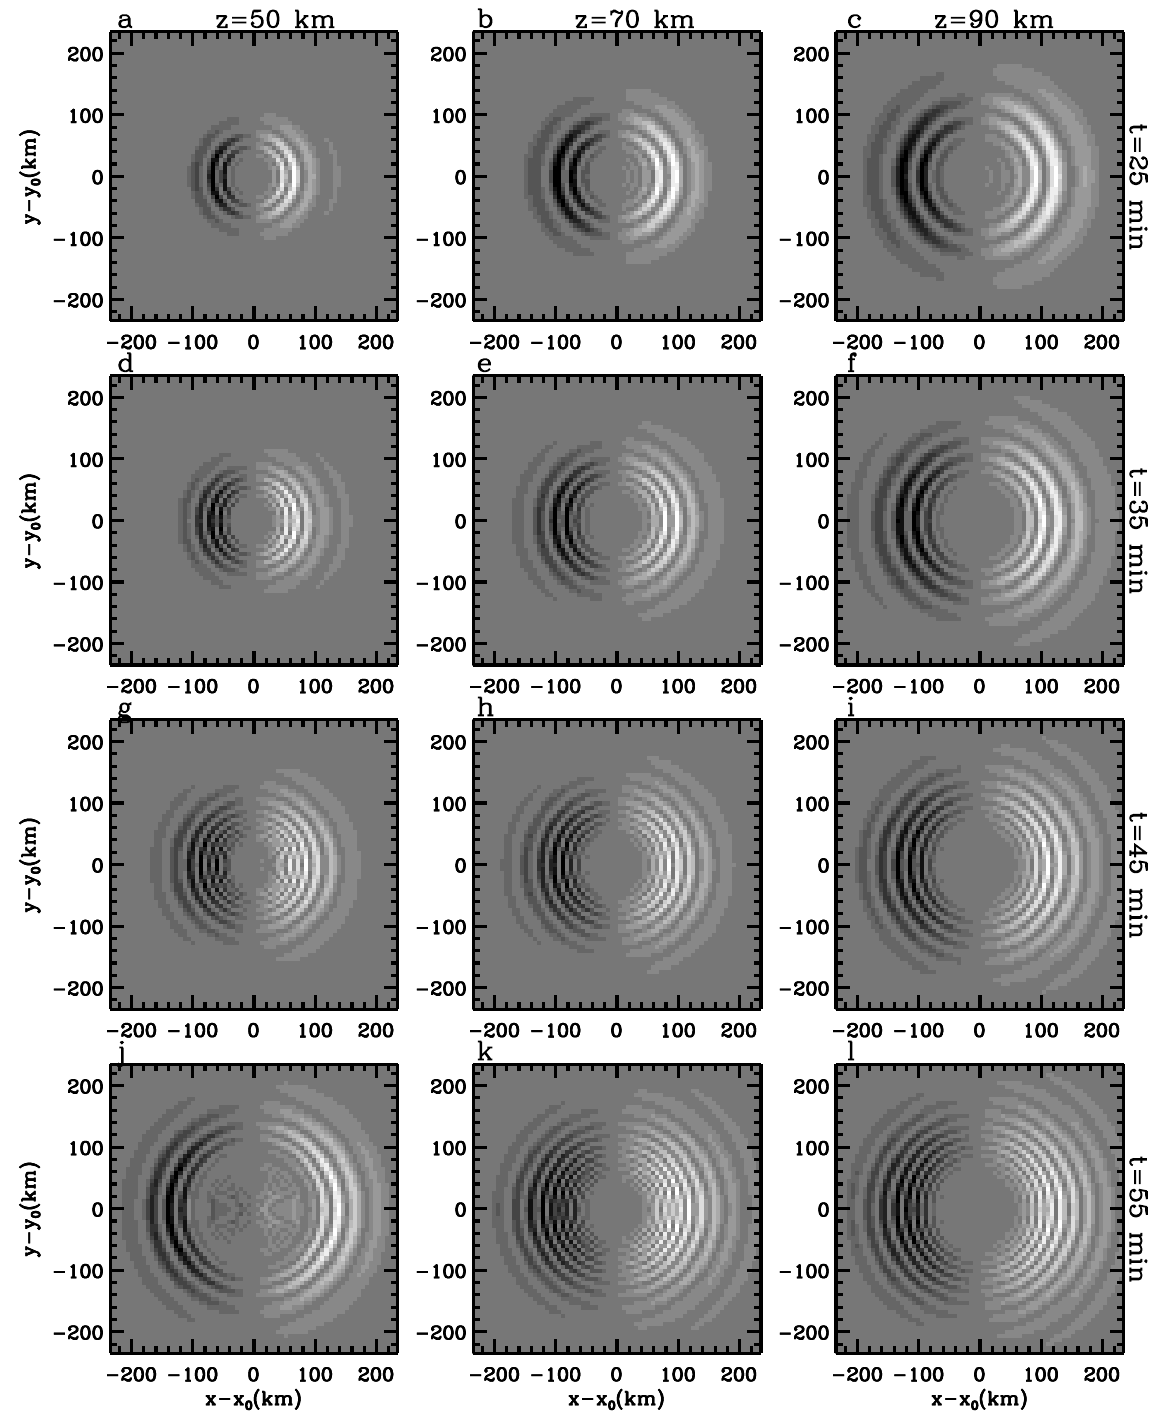
Fig. 5. Horizontal slices of the vertical flux of zonal momentum for a single convective plume with reflection using the FL solutions Fourier transformed to real space. The left, middle, and right columns show the GW response at z = 50, 70, and 90km, respectively. The upper to lower rows show the images at t = 25, 35, 45, and 55min, respectively. Maximum values (scaled for the decreasing background density) for each image are approximately twice those values shown in Fig. 10a–c as diamonds. Maximum positive values are white, while maximum negative values are black. The resolution is 1x = 6 .